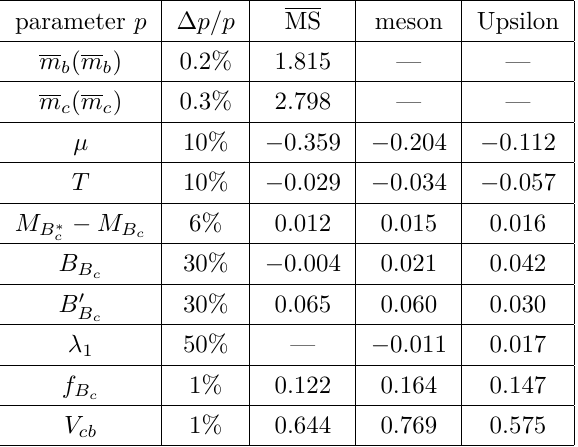
Table 5 . Error budget, varying individually the parameter p in the range ∆ p , leading to a change in the total rate of ∆Γ B mass